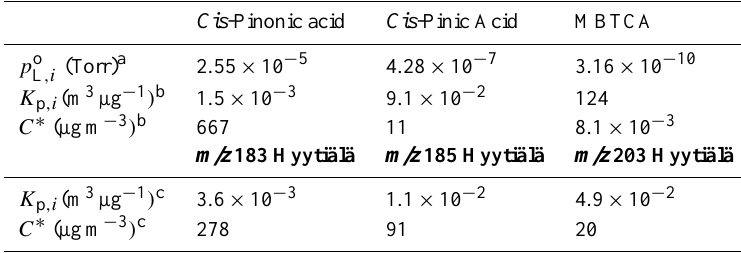
a Predicted by the SIMPOL.1 model at 294 K (Pankow and Asher, 2008). b Based on campaign average values of f om = 0 . 64 and MW om = 300 gmol − 1 , T = 294 K and γ i = 1 . c